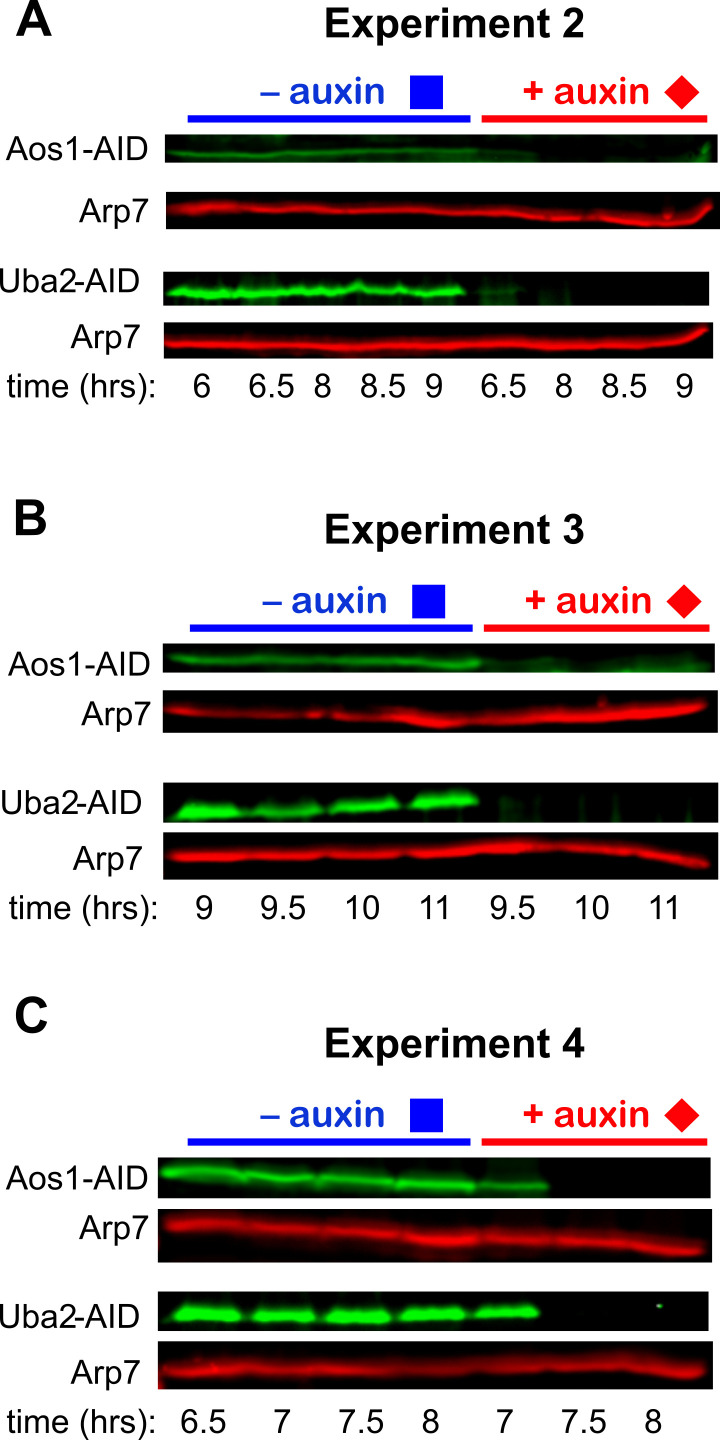
Degron-mediated depletion of Aos1 and Uba2.Immunoblots showing degradation of Aos1-AID and Uba2-AID after addition of auxin in (A) experiment 2, at the time of DSB formation; (B) experiment 3 at the time of strand invasion and synapsis; and (C) experiment 4 as cells resolve dHJs and exit pachytene. See Figure 3A for details.